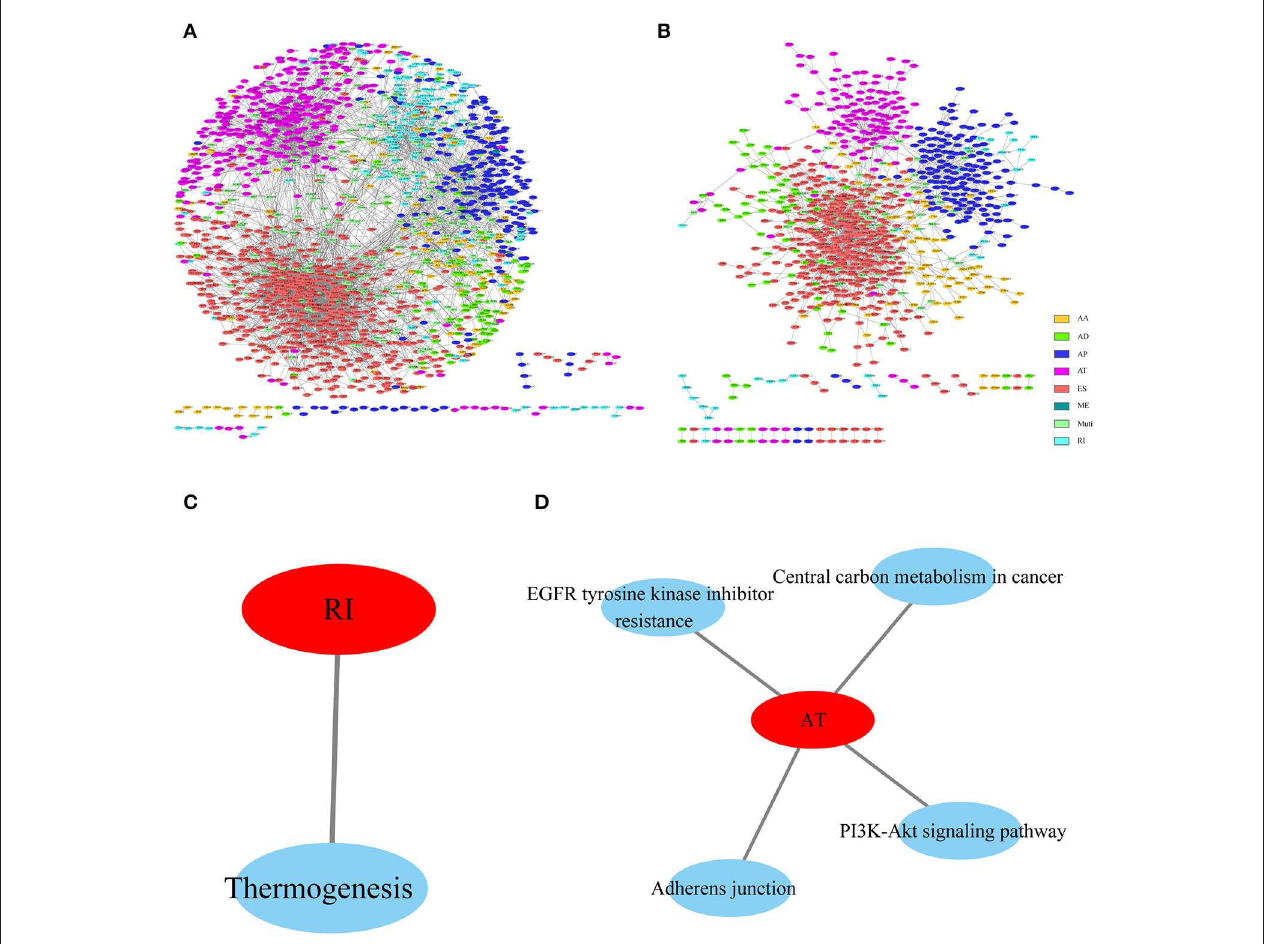
FIGURE 4 | Interaction network of genes with OS (A) - and recurrence (B) -associated AS events for HNSCC, created by Cytoscape. KEGG enrichment analysis of genes with OS (C) - and recurrence (D) -associated AS events.